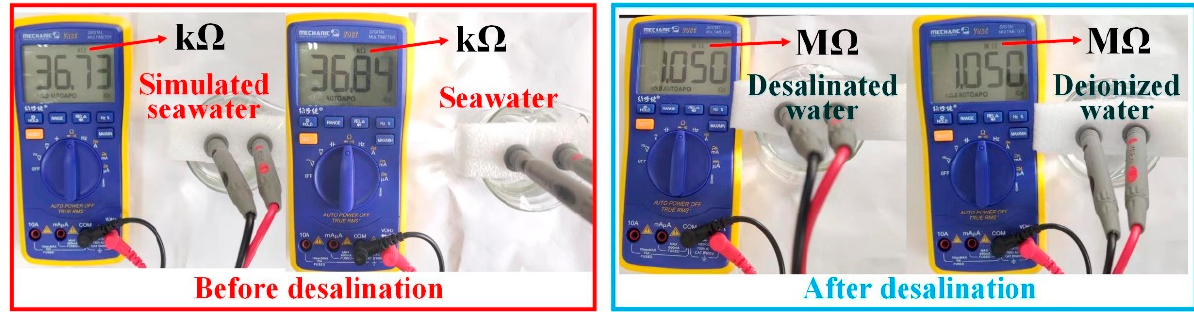
Figure 8. Comparison of resistance values of different water quality tested with a multimeter.